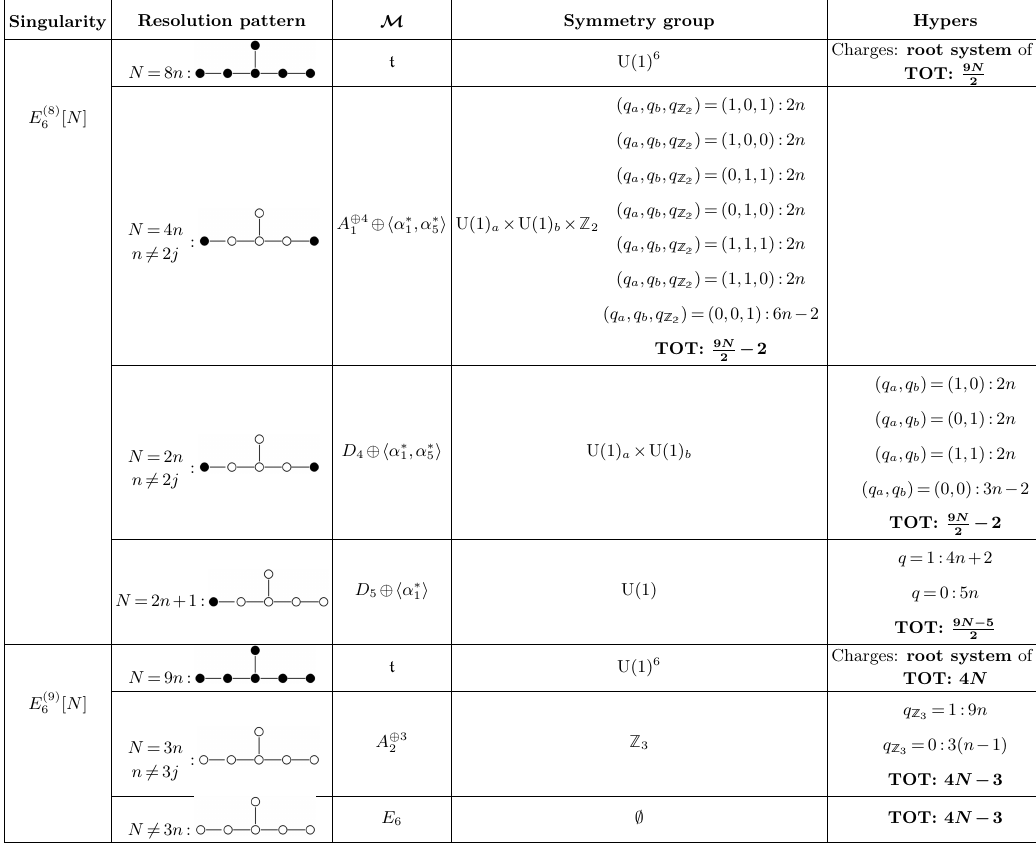
[ N ] and E (9) [ N ] 6 6